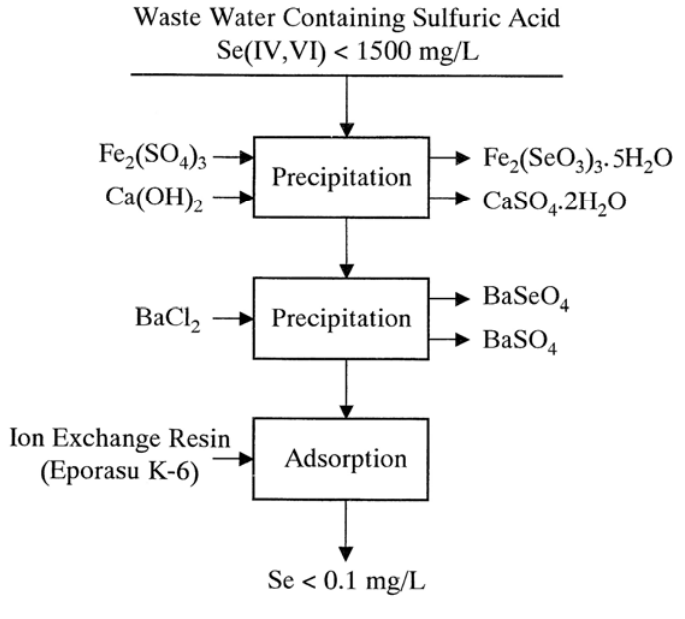
Figure 19. Flowsheet of process for removal of selenium from industrial waste